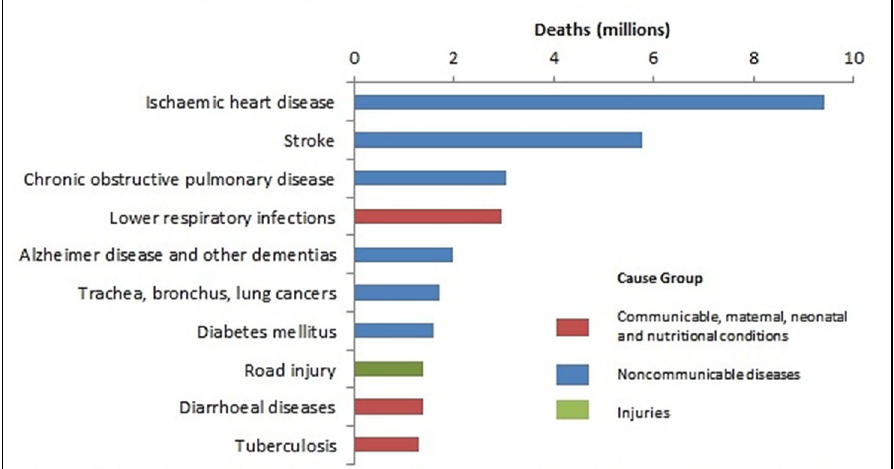
Figure 1. Top 10 Global Causes of Death, 2016